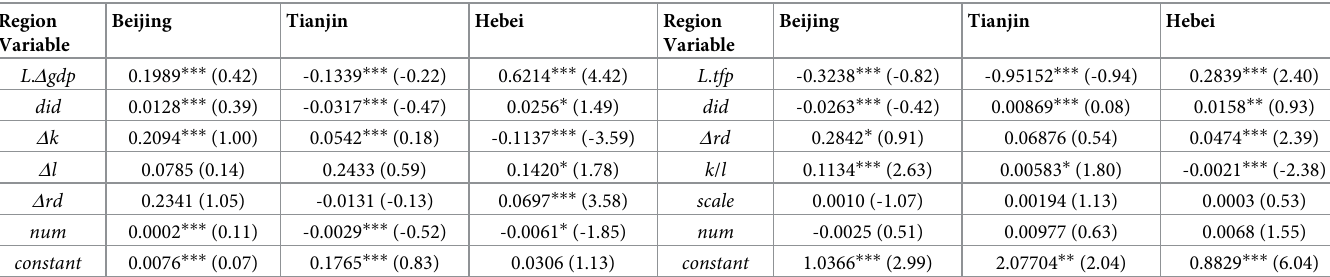
Table 7. Differential results of GDP growth rate and total factor productivity in Beijing, Tianjin and Hebei. Region Beijing Tianjin Hebei Variable did 0.0128 ***